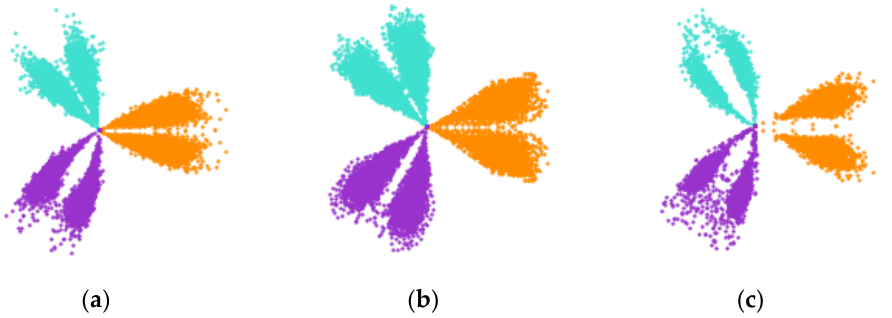
Figure 16. Clustering templates of sensor 1 in the three pitting level. ( a ) Normal; ( b ) Single pitting; ( c ) Double pitting.